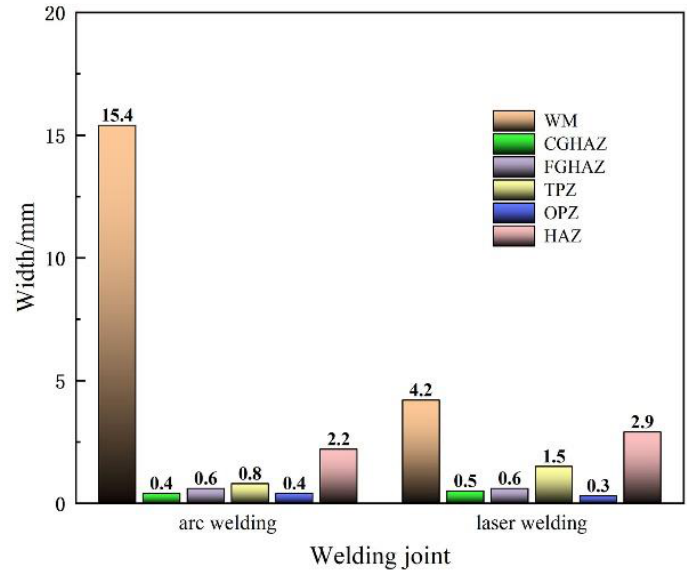
Figure 11. Dimensions of each zone in different welding joints.